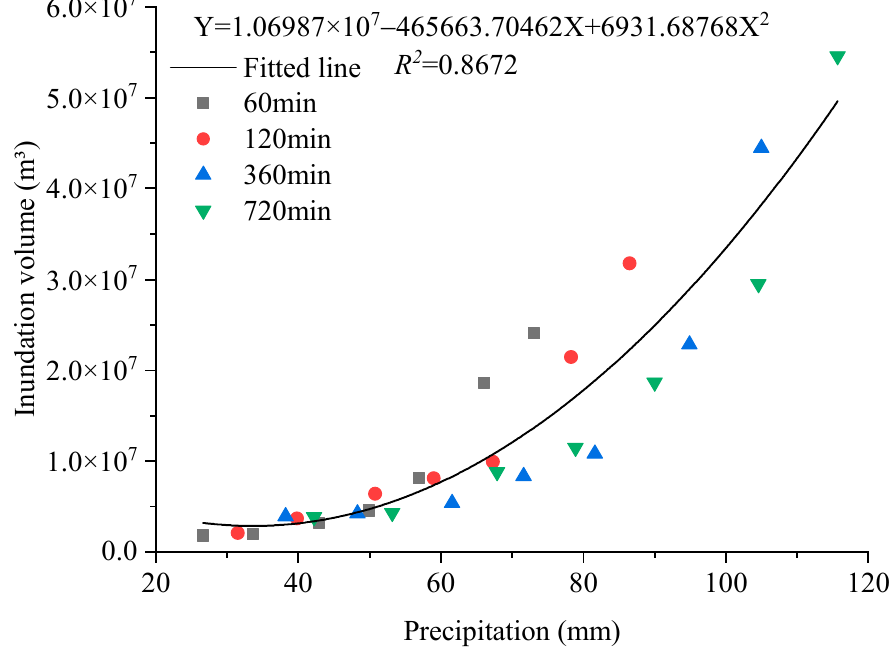
Figure 17. The relationship between submerged water volume and Precipitation.